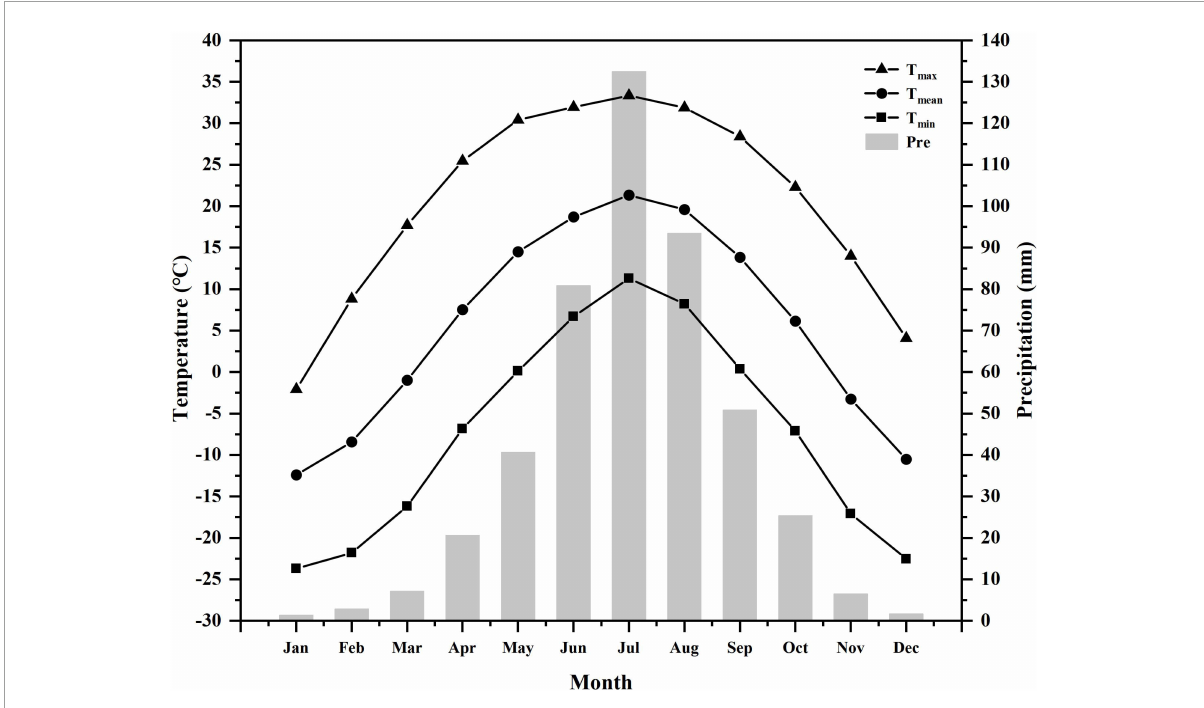
FIGURE2 Monthly maximum (Tmax), mean (Tmean), and minimum (Tmin) temperatures and monthly precipitation (Pre) for WeiChang county from 1990 to